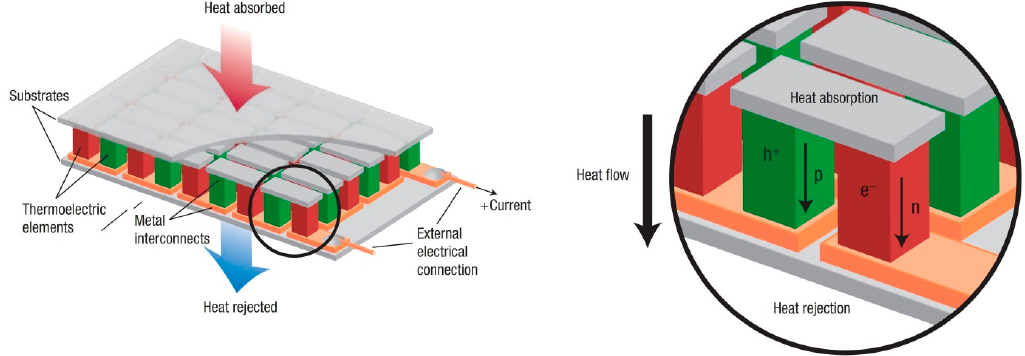
Figure 2. Schematic drawing of a thermoelectric generator; according to [2].